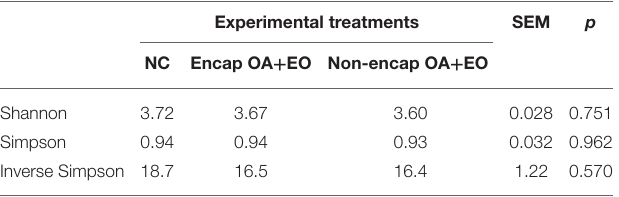
TABLE 4 | Effect of dietary treatments on microbiota α -diversity indices in cecal content of broiler chickens on day 35. Experimental treatments